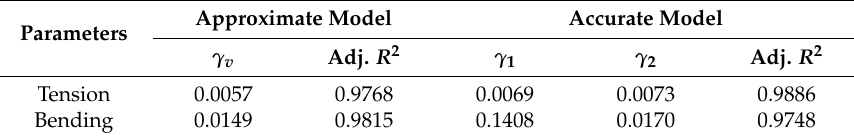
Table 1. The values of fitting parameters of two isotropic models.